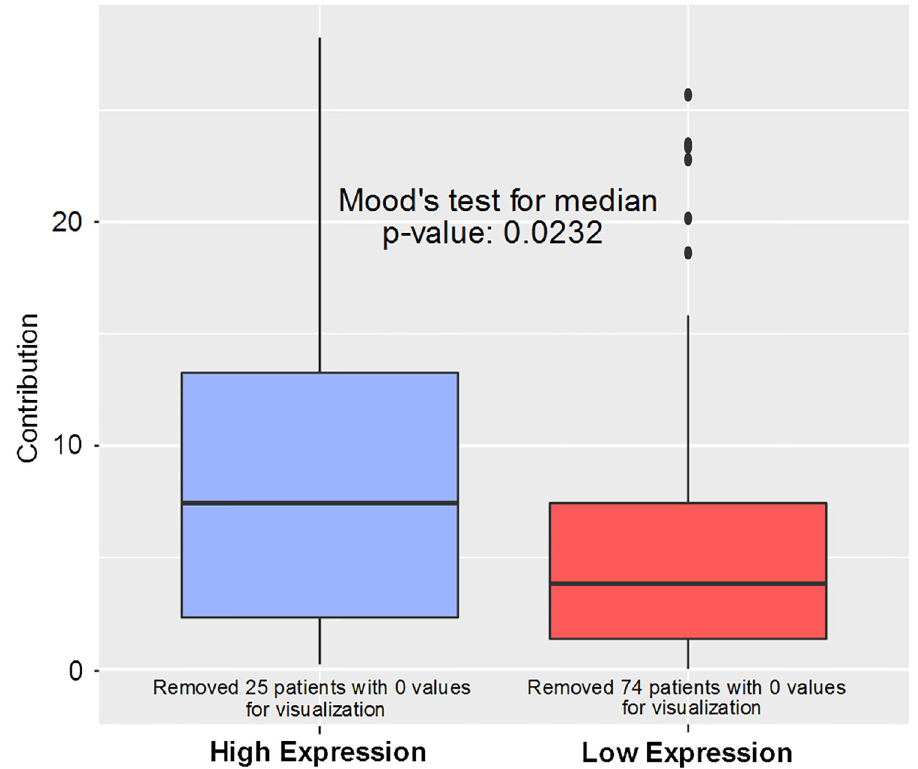
Fig 4. Mutation signature 3 association with RAD51C-202. Box-plots were generated for the signature 3 contribution to patients in low (red) and high (blue) expression of RAD51C-202. Patients with 0 values for contributions were removed for visualization. Signature 3 contributed more to the mutation signatures of patients with high RAD51C-202 expression than those with low expression.